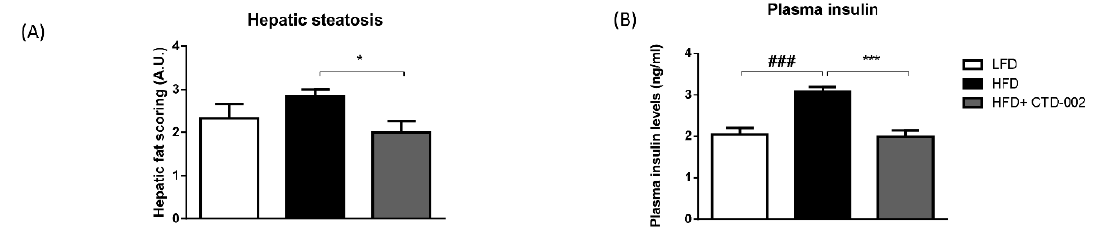
Figure 3. Metabolic parameters of high-fat diet (HFD)-fed Sprague – Dawley (SD) rats treated with or without the extracellular inhibitor CTD-002. ( A ) Scoring of hepatic steatosis by means of Hematoxylin-Eosin (H&E) staining. ( B ) Plasma levels of insulin. Error bars represent mean ± SEM; n = 6 for each group; * represents p < 0.05 and *** p < 0.001 compared to rats on HFD; ### represents p <